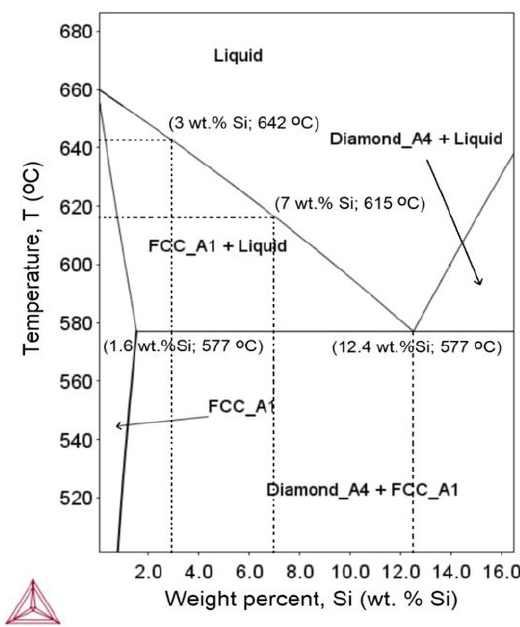
Figure 6. Temperature profiles for each position of the thermocouples: a) Al - 3 wt. % Si alloy, and b) Al - 7 wt. % Si